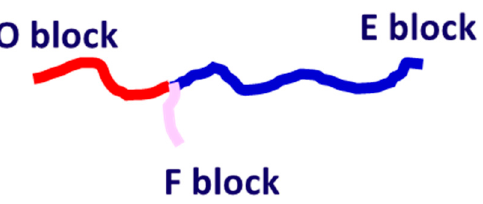
Figure 1. Schematics of the star block copolymers and color codes of individual polymer blocks. Table 1. Interaction parameters a ij (in DPD units) used in the simulations. Type of